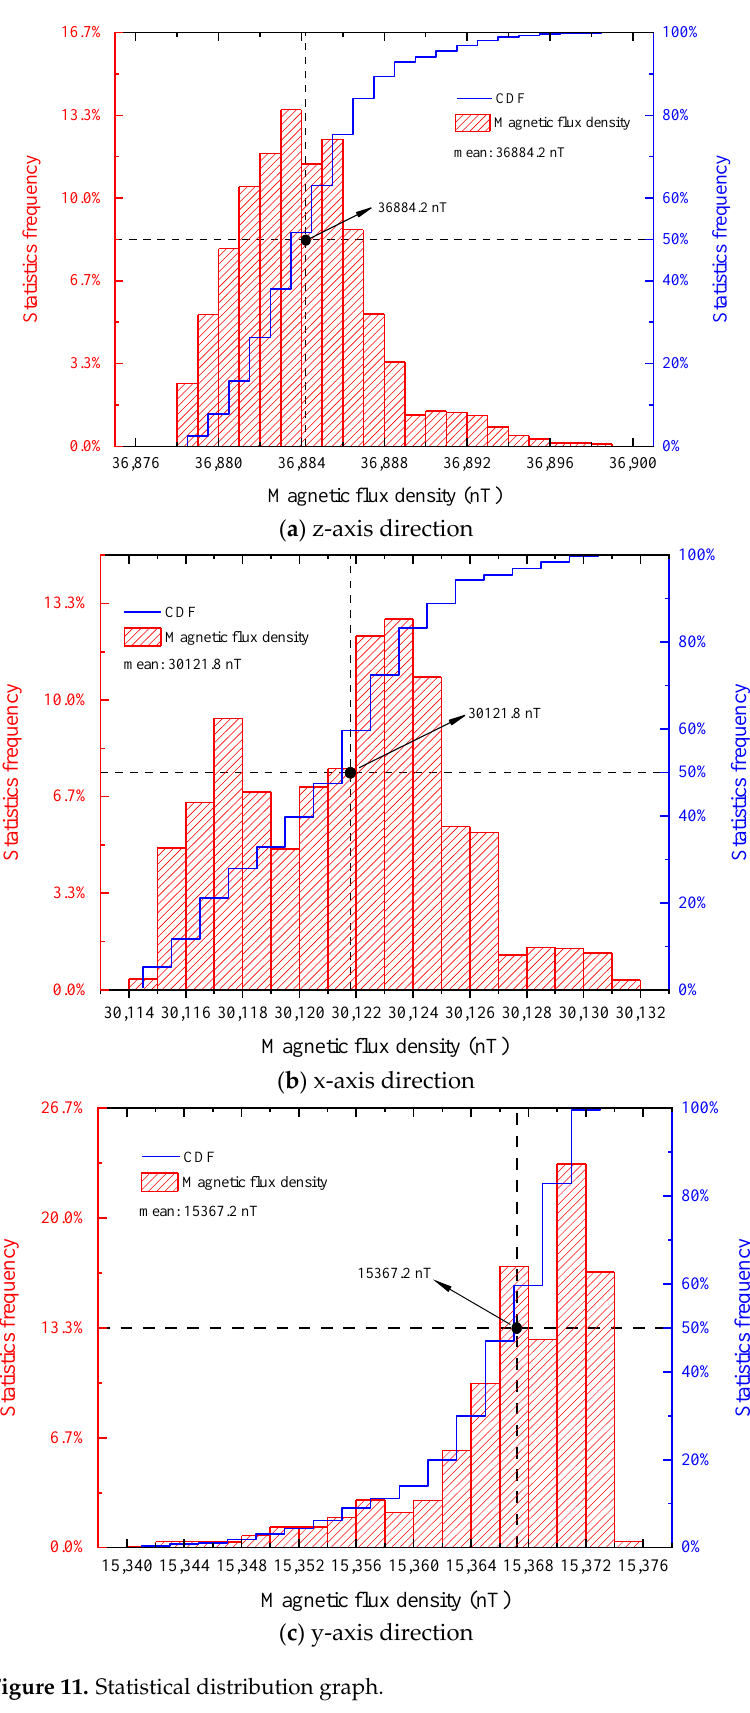
Figure 11. Statistical distribution